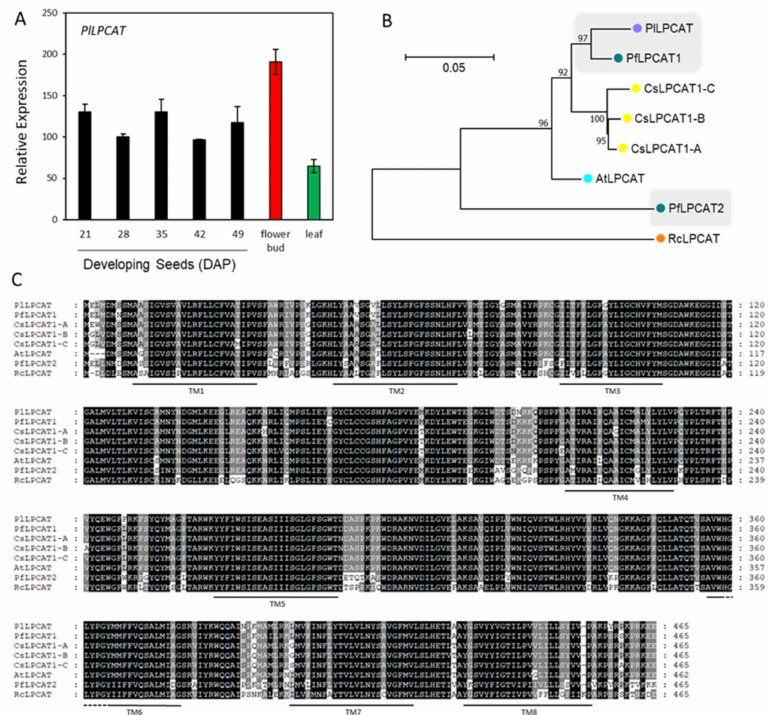
Figure 5. Characterization of LPCAT proteins. ( A ) Relative expression level of PlLPCAT in developing seed, flower, and leaf tissue by qRT-PCR. DAP; day after pollination. ( B ) Phylogenetic tree of LPCAT proteins in various species. Physaria lindheimeri , Physaria fendleri were highlighted with grey background. ( C ) Amino acid alignment of LPCAT protein sequence in Physaria lindheimeri (Pl), Physaria fendleri (Pf), Arabidopsis thaliana (At), Camelina sativa (Cs), and Ricinus communis (Rc). Putative transmembrane domains were underlined. Genbank accession numbers were listed in Supplementary File 6, Table